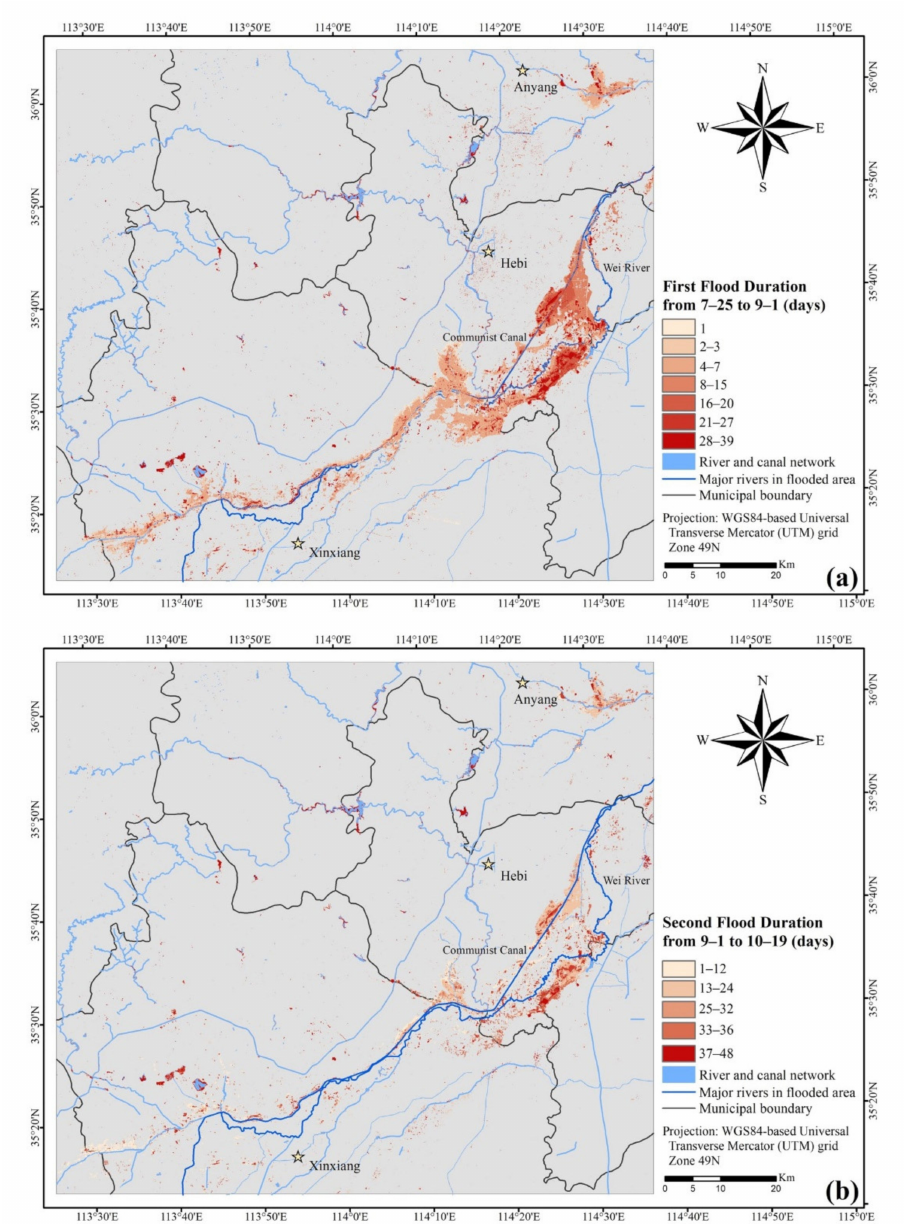
Figure 6. Spatial distribution and duration of inundation of the first flood (from 26 July to 1 September) ( a ) and for the second flood (from 1 September to 19 October) ( b ). The figure was plotted by Arcmap10.2